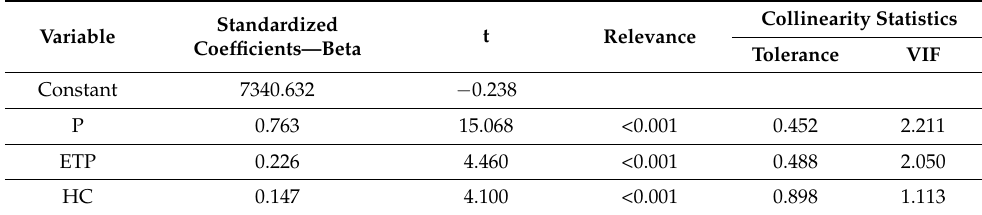
Table 6. Coefficients in the regression model of greenhouse gas emissions in 2020.